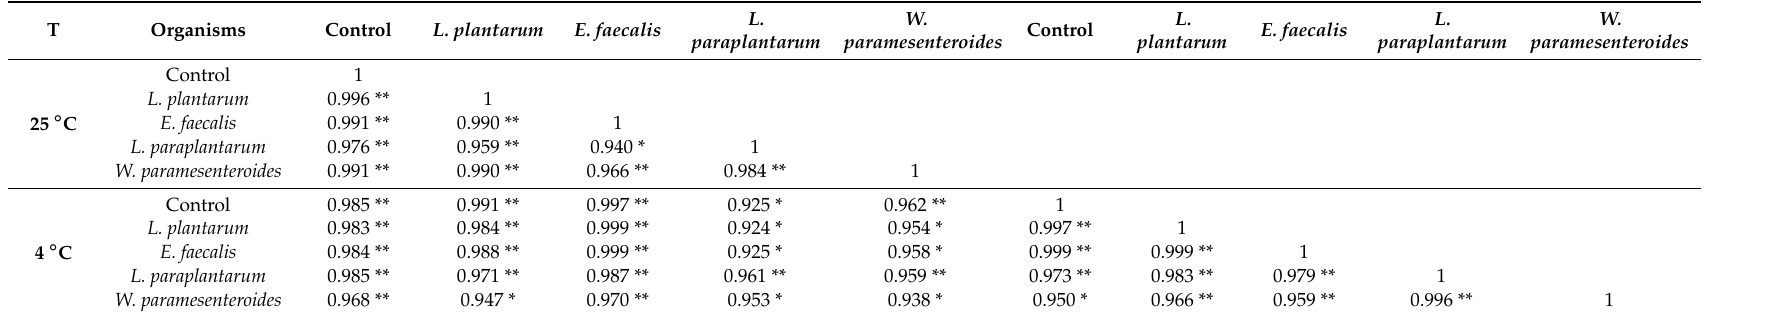
Table 5. Pearson’s correlation coe ffi cients of the pH values in the grape marmalade at both 25 ◦ C and 4 ◦